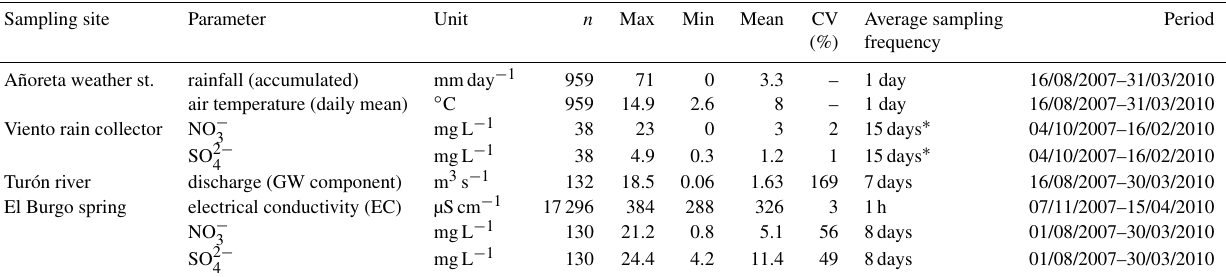
Table 1. Main characteristics of the time series of hydrodynamic and hydrochemical data used in this study. CV is the coefficient of variation. Sampling site Parameter Añoreta weather st.